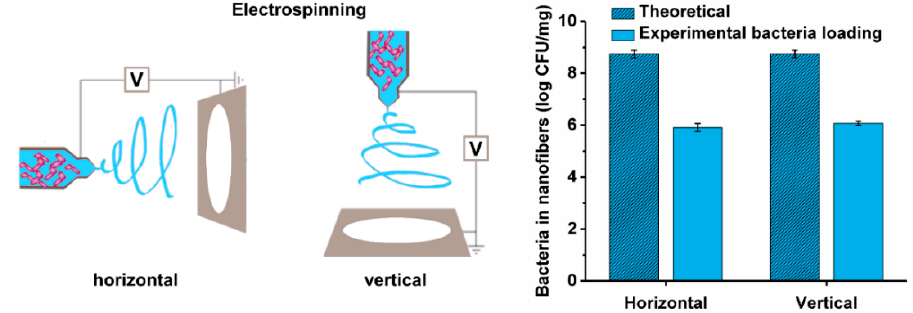
Figure 5. Theoretical and experimental loading of Lb. delbrueckii ssp. bulgaricus in nanofibers using either horizontal or vertical electrospinning.